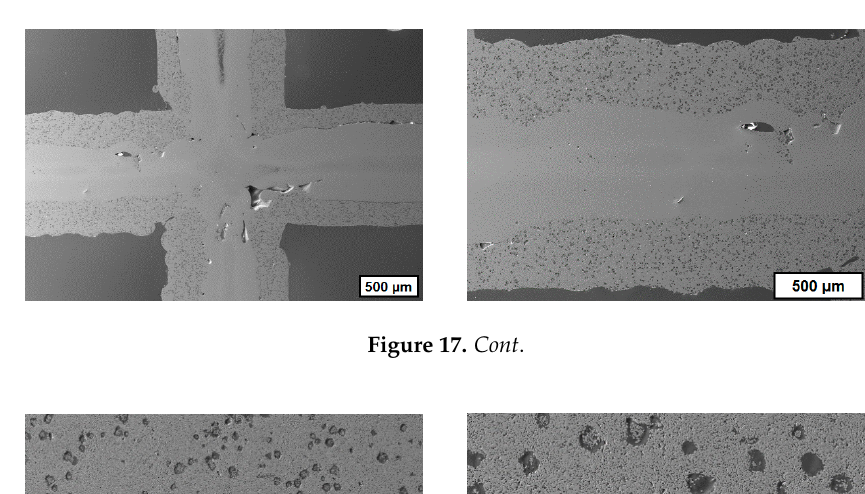
( d ) Figure 15. Green honeycombs additively manufactured with different suspensions: ( a ) C&G, ( b ) C&G, ( c ) C&G, and ( d ) A&F.